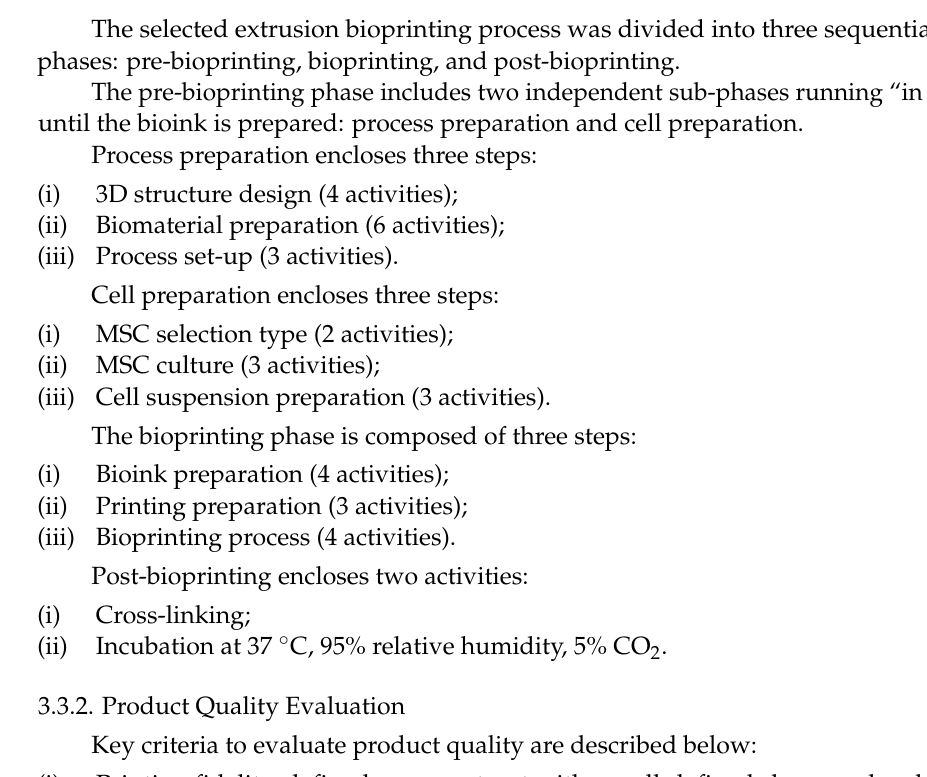
Figure 1. Schematic sequential representation of process phases.